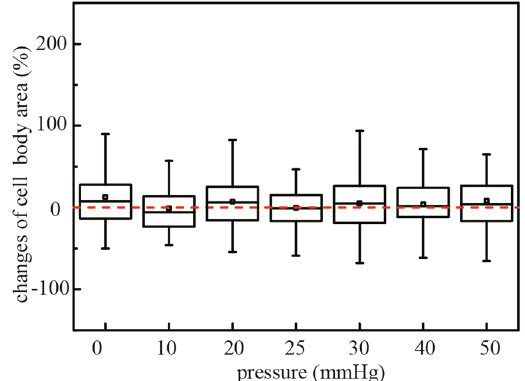
Figure 6. Box plot of cell body area changes after applied hydrostatic pressures of 0 mmHg (n = 155 RGCs), 10 mmHg (n = 67 RGCs), 20 mmHg (n = 109 RGCs), 25 mmHg (n = 77 RGCs), 30 mmHg (n = 76 RGCs), 40 mmHg (n = 80 RGCs), and 50 mmHg (n = 74 RGCs) for 72 hours. Box plot whiskers indicate the maximum and minimum values of the data. The symbols * , # and + indicate statistically different results from 0 mmHg (P < 0.05), 10 mmHg (P < 0.05), and 20mmmHg (P < 0.05) respectively by one-way ANOVA followed